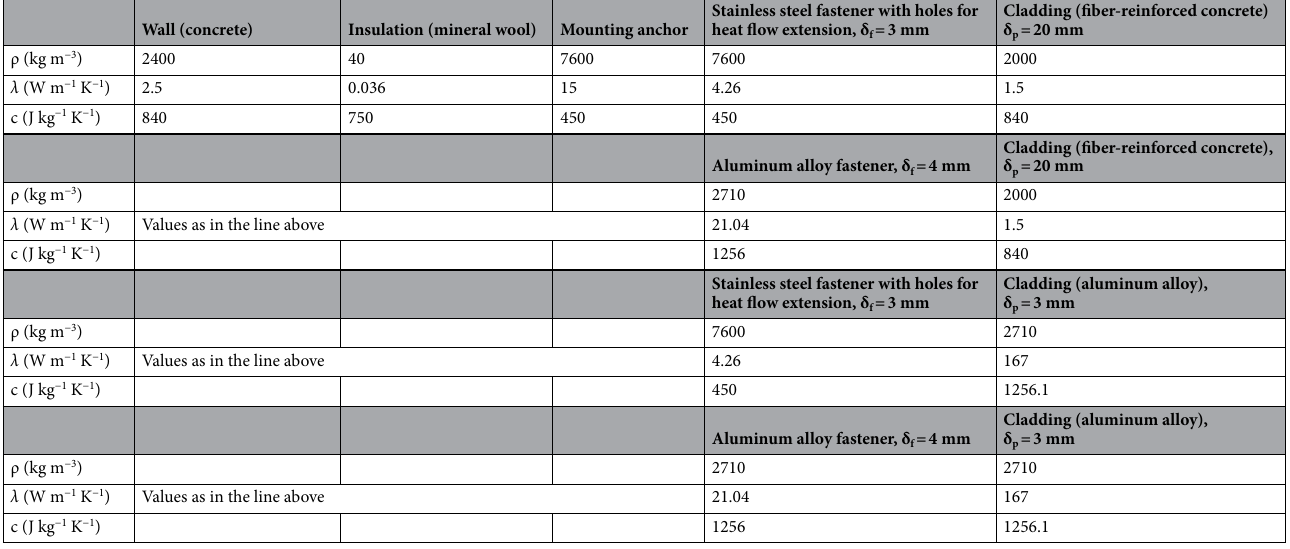
Table 4. Materials data for the multilayer wall. Variant 1: external cladding made of fiber-reinforced concrete, δ p = 20 mm; variant 2: cladding made of aluminum alloy, δ p = 3